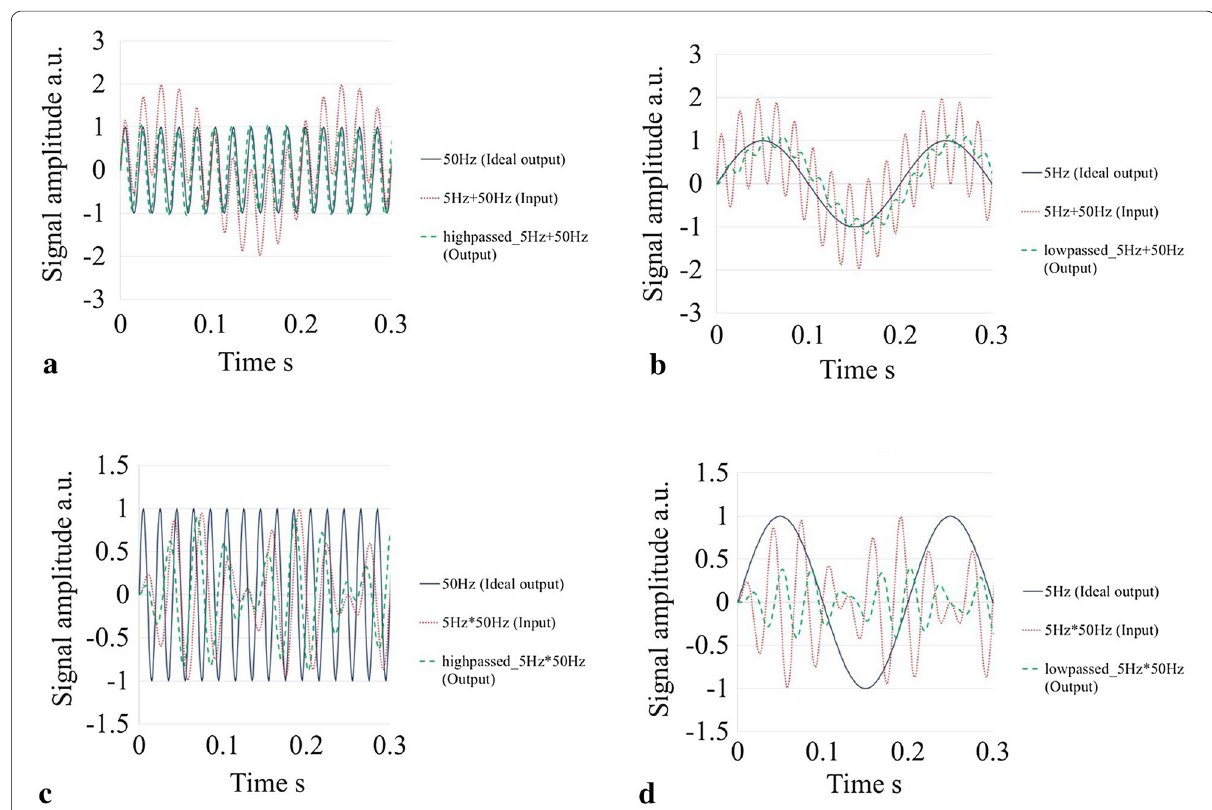
Fig. 4 Effect of high-pass filter (HPF) and low-pass filter (LPF) for two types of noise. In this example, a second-order Butterworth filter with a cutoff frequency of 20 Hz is used as both an HPF and an LPF to process two kinds of noise. In all four graphs, the red dotted line shows the input signal, which is made of two frequency component signals, one being additive and the other multiplicative; the green dashed line shows the output signal of the filters; and the dark blue line shows the ideal output of the filters (in the case of using an LPF, a low-frequency component is ideal output, and in the case of using an HPF, a high-frequency component is ideal output). a Additive noise processed with HPF. b Additive noise processed with LPF. c Multiplicative noise processed with HPF. d Multiplicative noise processed with